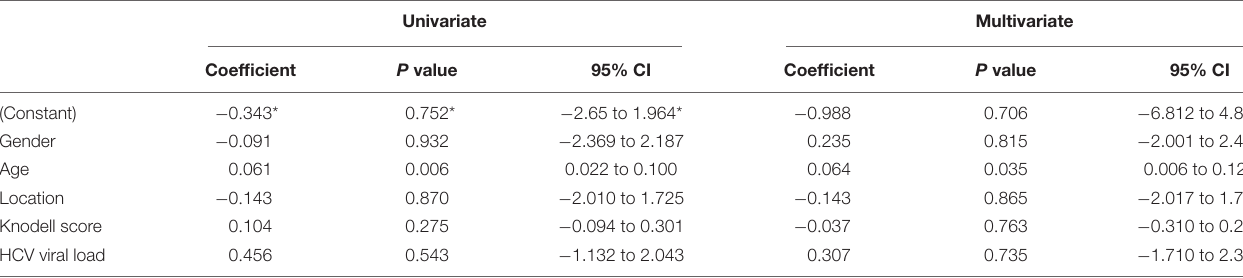
TABLE 1 | Regression analysis of the effects on SOCS-1 expression in non-HCC tissue sections. Univariate